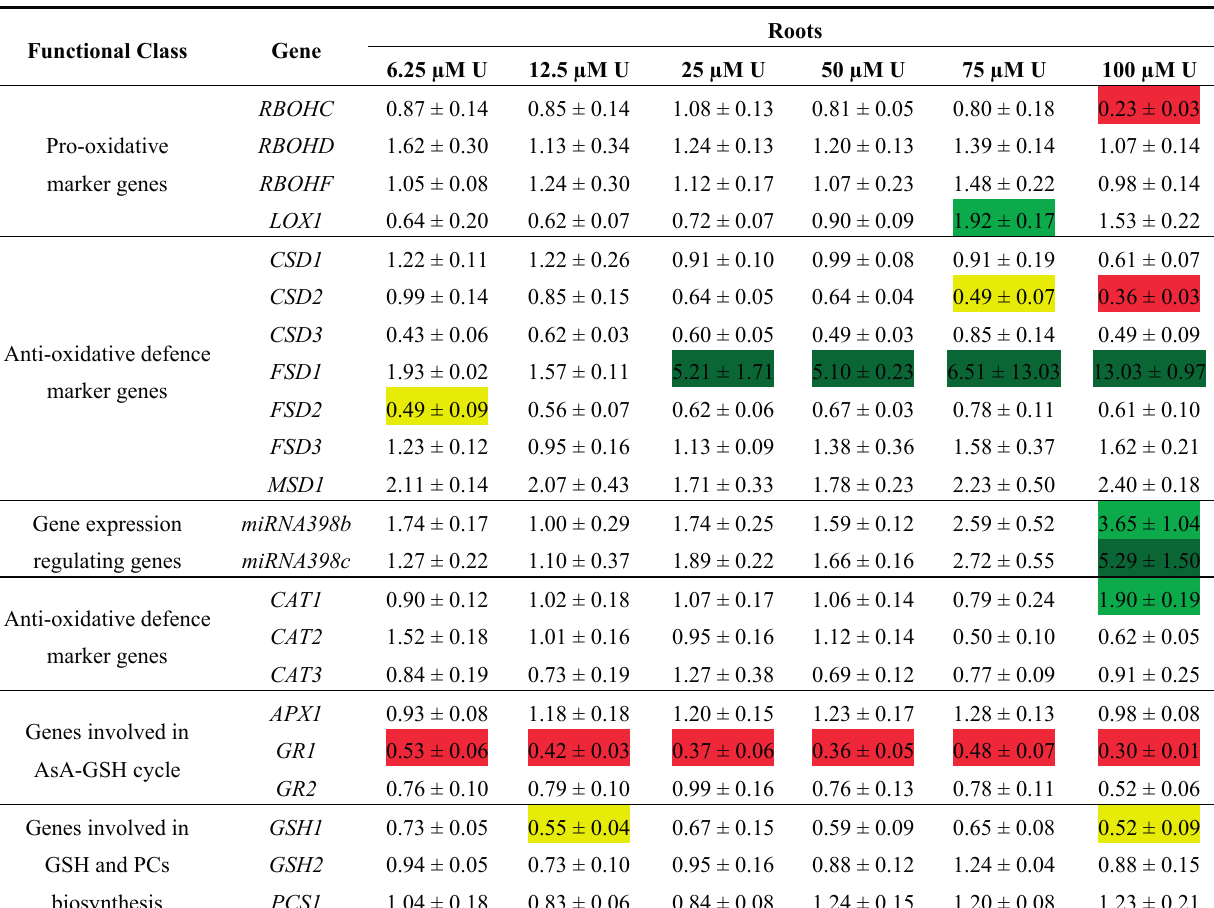
1. Values represent the mean ± S.E. of at least 3 biological replicates. Significant